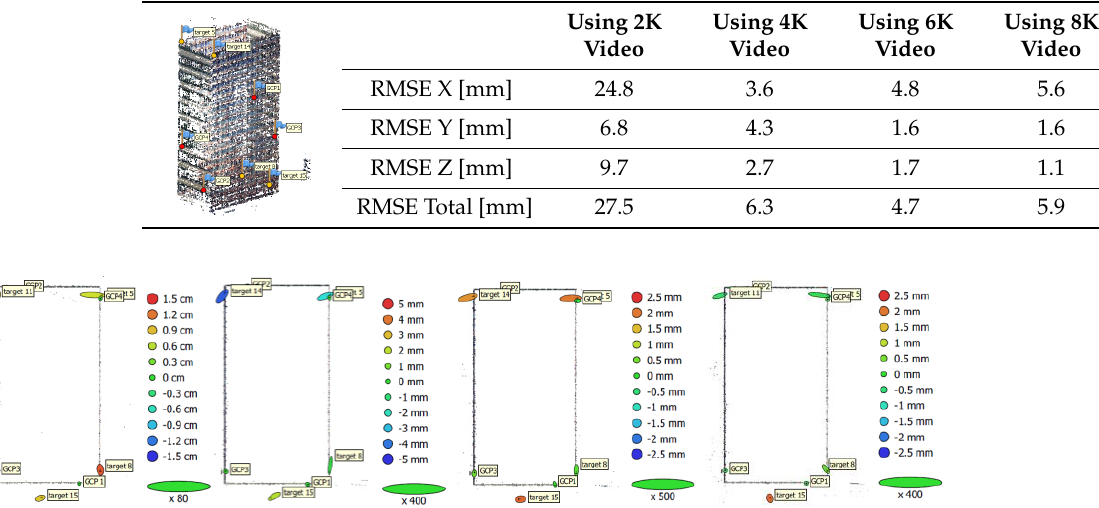
Figure 16. Top view of the checkpoints and GCPs exaggerated error ellipses visualization of the building facades at the four drone video resolutions. The error in Z is represented by ellipse color while XY errors are represented by ellipse shape using the Metashape tool.